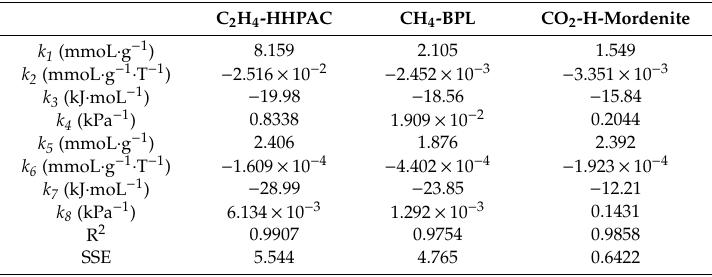
Table 9. The TDSL model parameters and errors for di ff erent systems.